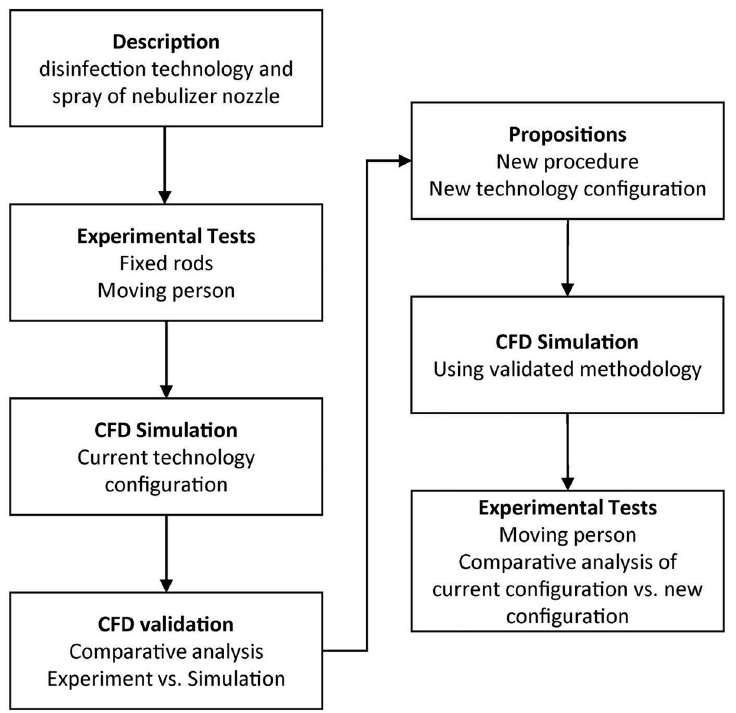
Fig 1. General scheme of the methodology used in this study to evaluate the performance of the disinfection technology (chamber) in relation to the dispersion of the biocidal